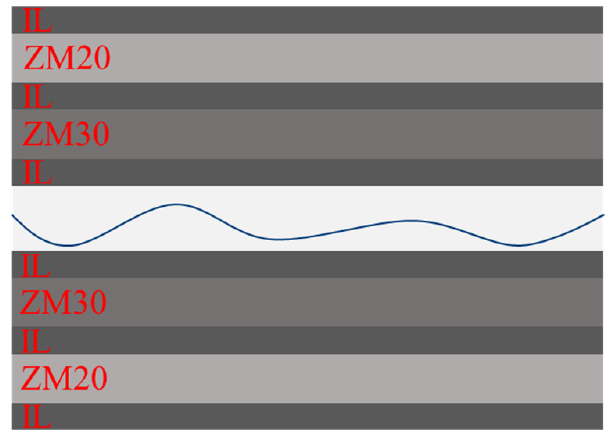
Figure 1. Schematic illustration of the designed laminated ceramics: ZM20 (80 wt.%ZrB 2 -20 wt.%Mo 5 SiB 2 ), IL (70 wt.% Mo-30 wt.%Mo 5 SiB 2 ), ZM30 (70 wt.%ZrB 2 -30 wt.%Mo 5 SiB 2 ).